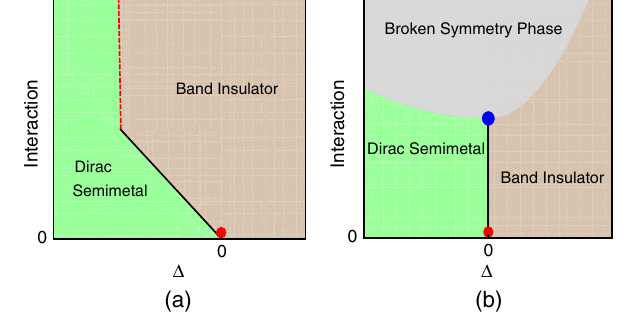
FIG. 2. Schematic phase diagrams of a two-dimensional Dirac material, residing in close proximity to the Dirac-semimetal to band-insulator quantum critical point (the red dot), in the presence of generic short-range interactions. Critical fermions possessing anisotropic dispersion are found along the black line in either subfigure. This direct transition can be avoided in two separate scenarios: (a) a strong-coupling scenario in which the critical anisotropic semimetal (ASM) is replaced by a line of first- order transitions (red dashed line) and (b) an alternative scenario in which the ASM becomes unstable to the formation of a broken- symmetry phase. In this case, the blue dot represents a multi- critical point separating the ASM from spontaneous ordering. Charge density wave, antiferromagnet (N´eel), and s -wave super- conductivity are the prominent candidates for the broken- symmetry phase [see also Fig. 4(b) and Fig. 12]. For weak coupling in (a), the only effect of the interactions is to shift the phase boundary separating the band insulator and Dirac semi- metal. In (b), we assume that any such shift is compensated by the bare anisotropy ( Δ ). We do not here discuss instabilities of the Dirac semimetal (see text for discussion on this issue